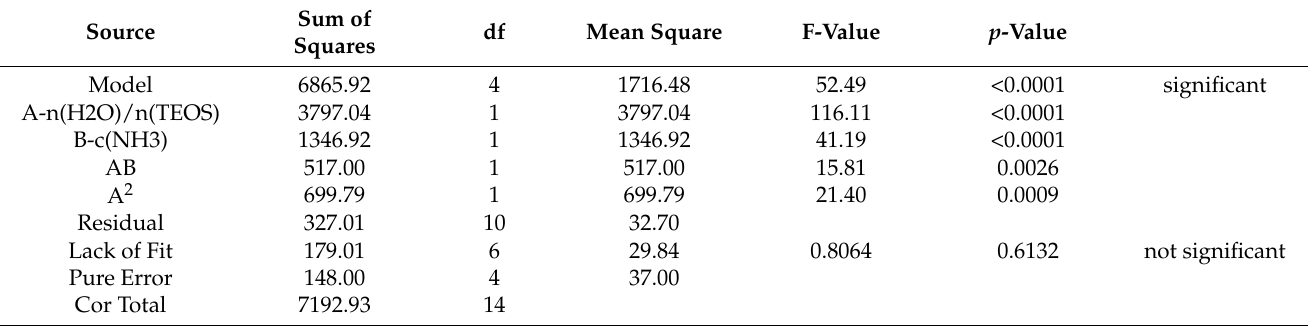
Table A6. Analysis of variance (ANOVA) for the analysis of the FCD design of the SNP